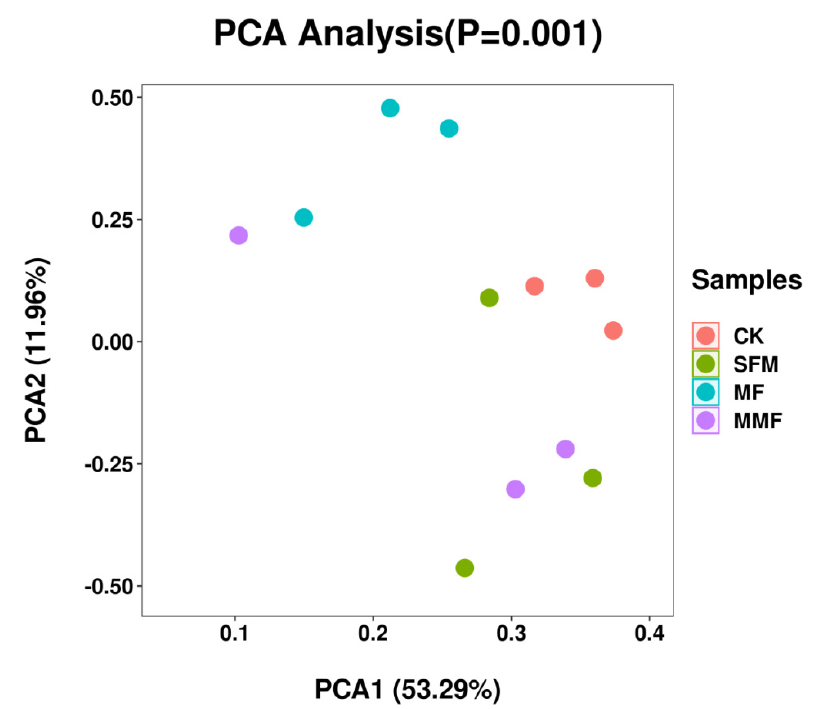
Figure 2. Principal Component Analysis (PCA) showing fungal and bacterial overall structural changes of Lanzhou lily rhizosphere soil among different treatments from Illumina NovaSeq.